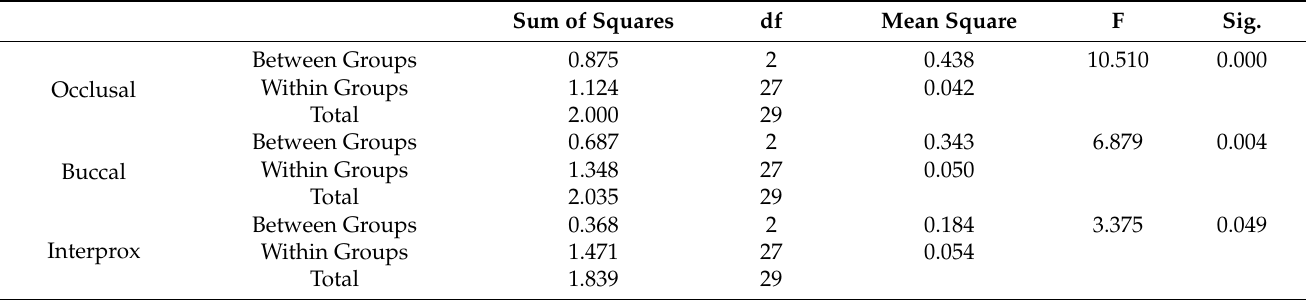
Table 1. One-way ANOVA analysis between the three surfaces of the study and master models. Sum of Squares